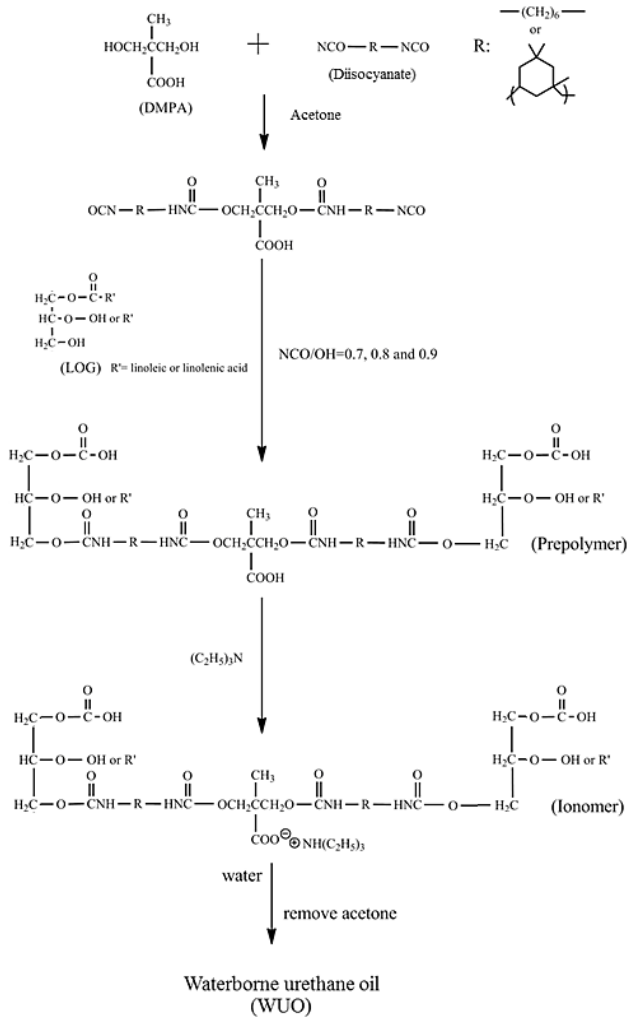
Figure 1. Synthesis process of waterborne urethane oil (WUO).